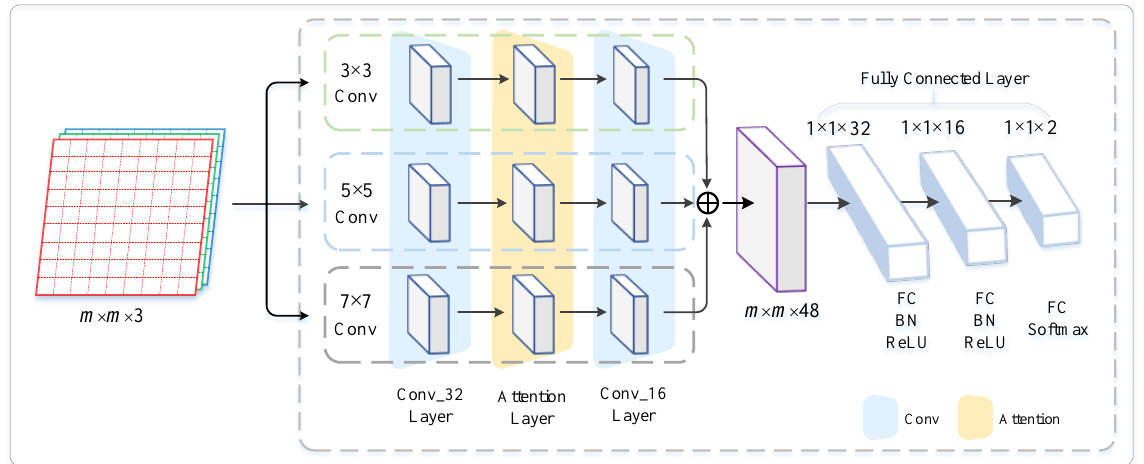
Figure 5. The proposed network framework of MSCNN-AM for point clouds filtering.